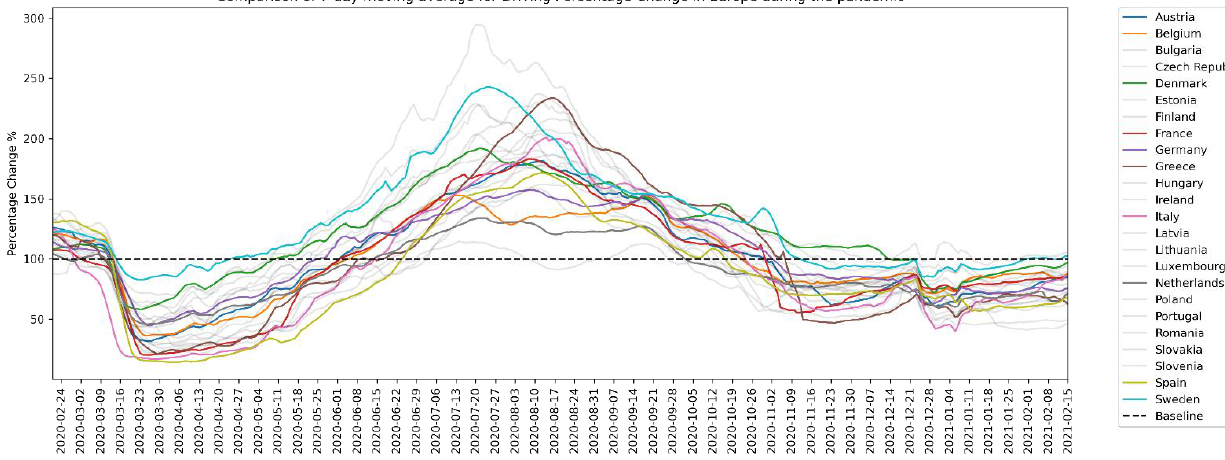
Figure 2. Comparison of 7-day moving average for driving percentage change in Europe during the pandemic (Source: Apple)